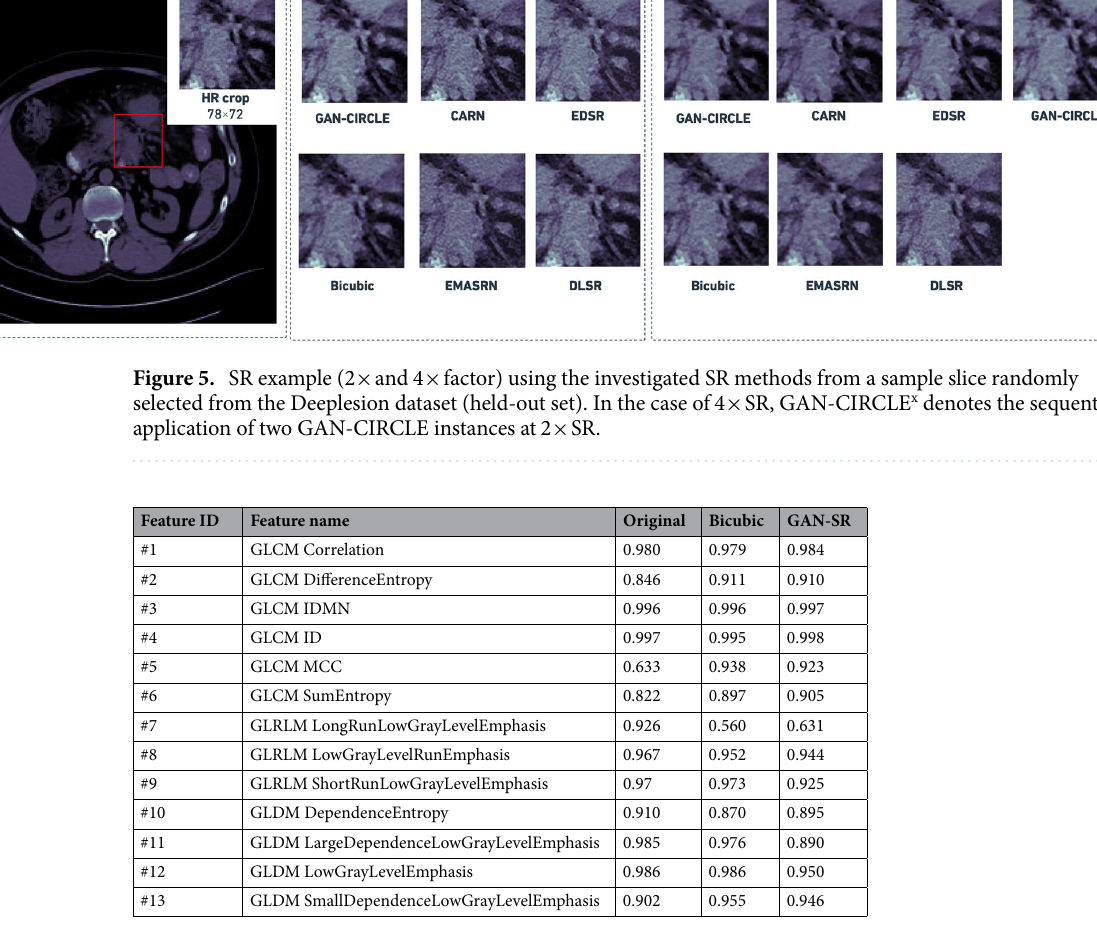
Table 1. Features that obtained an excellent robustness for at least of the Original, Cubic and GAN-SR image groups.